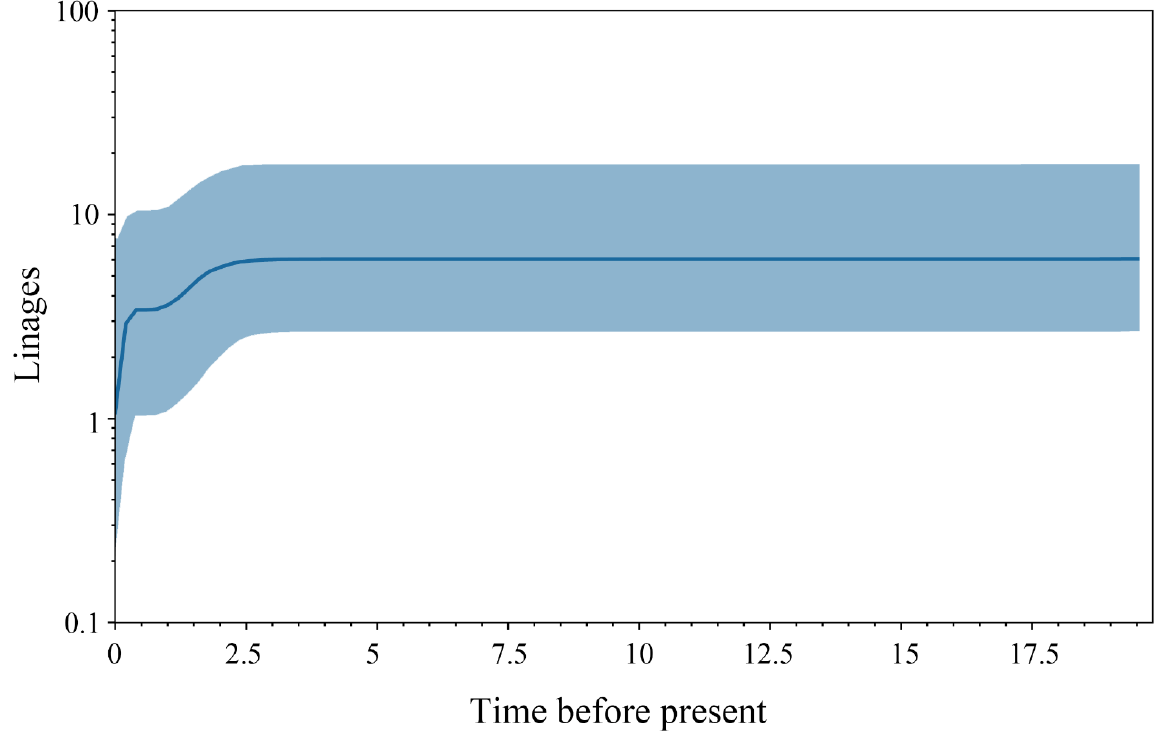
Figure 6. Bayesian skyline diagram of the population dynamic for populations of M. remanens . The areas shaded in light blue are within the 95% of highest posterior density interval. The dotted vertical lines indicate the important population size changes of M. remanens . A distribution map of the ancestral region indicated that M. remanens in Hunan Prov- ince originated in Region B (the central part of Hunan Province) (Figure 7). It then spreads from Region B to Region C (northern part of Hunan Province) and Region A (southern part of Hunan Province).